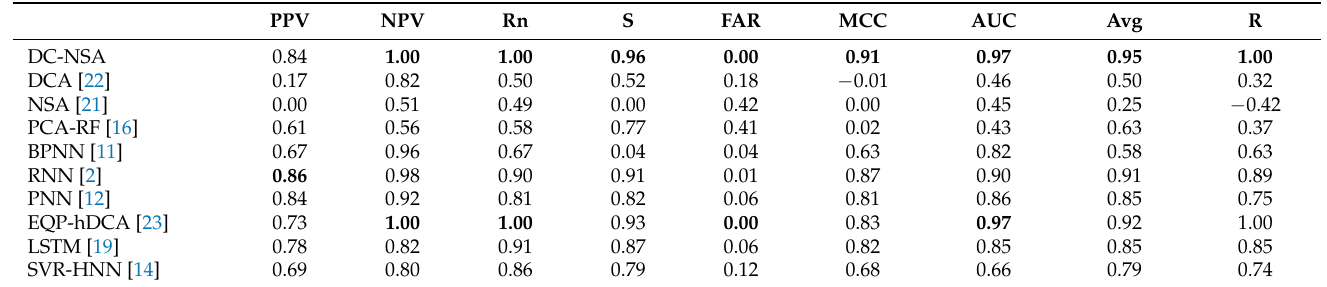
Table 6. Comparison between DC-NSA and other approaches when predicting DS2. The best results are in bold.